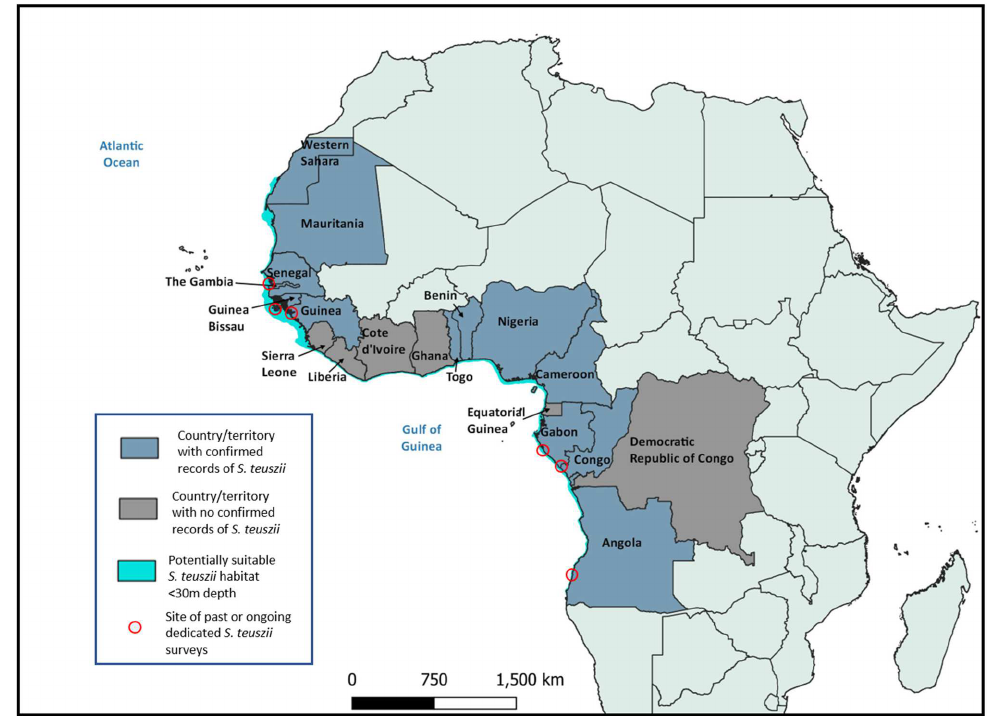
Figure 1. Distribution of Atlantic humpback dolphins ( Sousa teuszii ). Note that confirmed records are only available from 13 of the 19 possible range countries. For those countries where no records have been confirmed, it is unknown whether this is due to a lack of dedicated survey effort or true gaps in the species’ range.